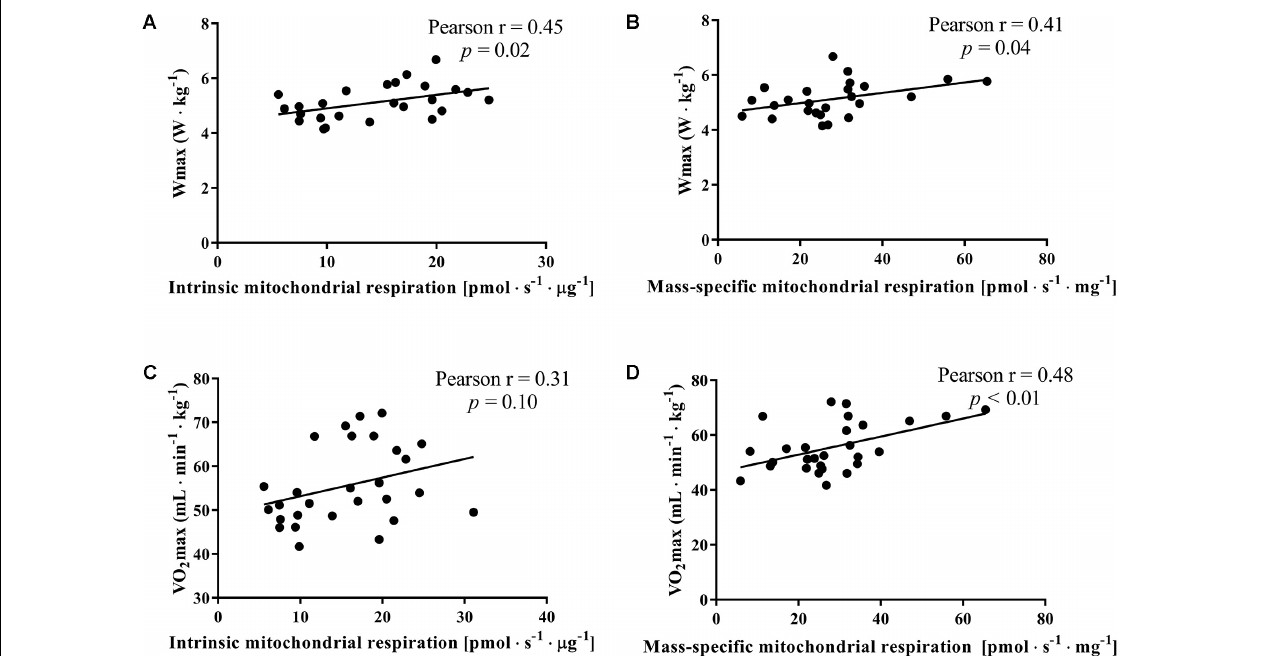
FIGURE 4 | Correlation between the maximal mitochondrial oxidative phosphorylation (State 3 complex I + II P ), maximal cycling power output (W max ) achieved on a gradual incremental exercise test and maximal oxygen consumption (VO 2max ) for the whole group of subjects. Maximal mitochondrial oxidative phosphorylation was normalized for mitochondrial protein content (intrinsic mitochondrial respiration; A,B ) and for initial wet weight (mass-specific mitochondrial respiration; C , D